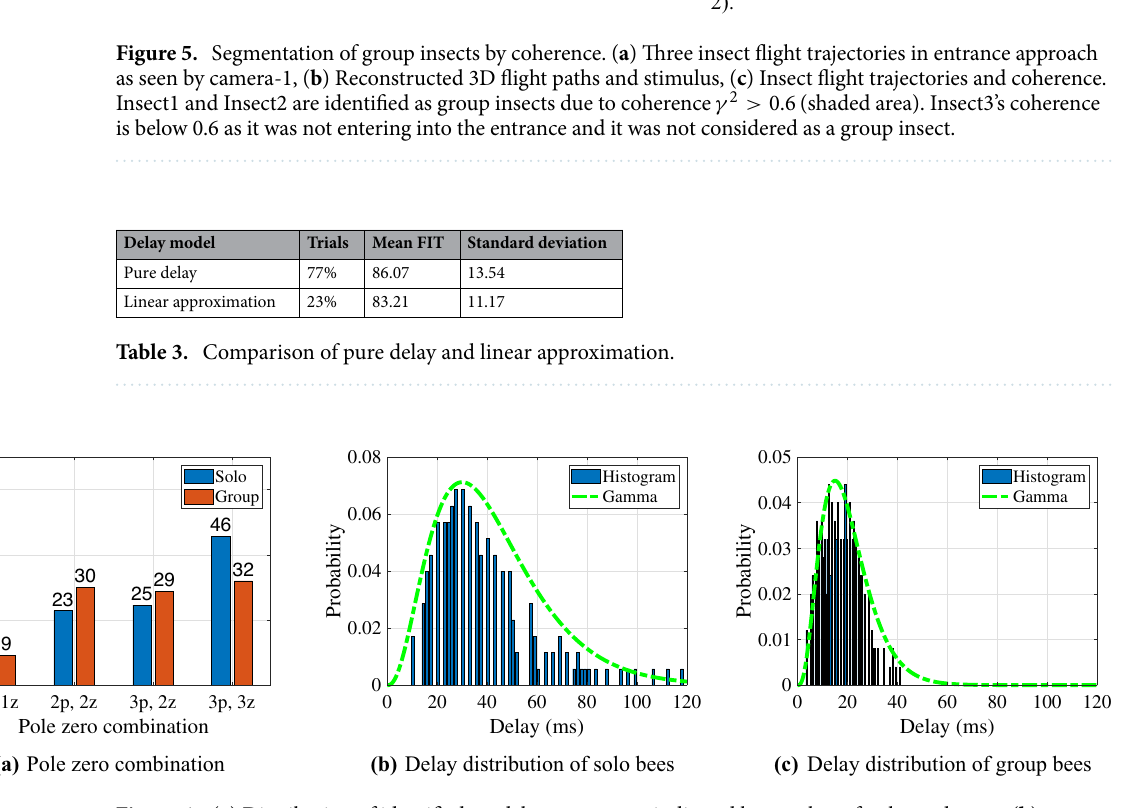
Figure 6. ( a ) Distribution of identified model structures, as indicated by number of poles and zeros, ( b ) histogram of solo insect delays vary from 0 to 120 ms and normalized gamma distribution, ( c ) histogram and fitted distribution curve in group bees, containing a narrower band of delays from 0 to 45